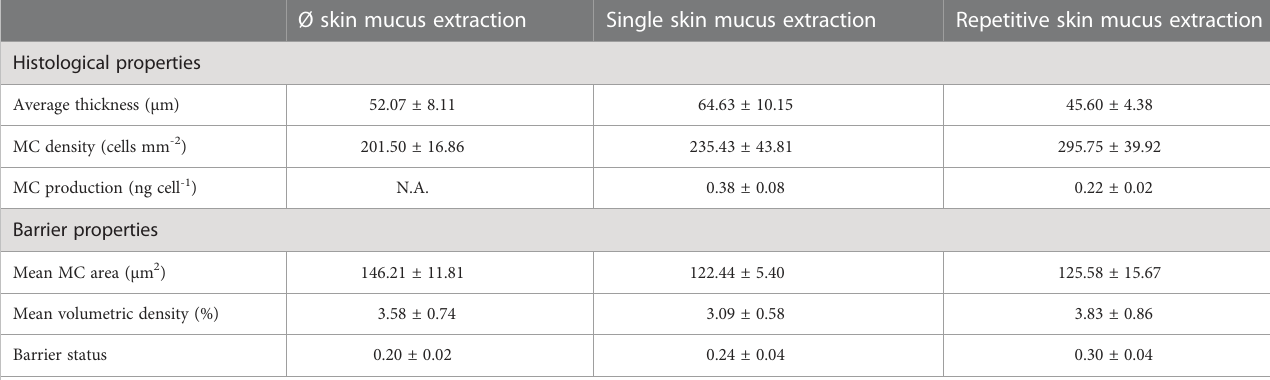
TABLE 3 Histological and barrier properties of gilthead sea bream skin subjected to zero, single or repetitive skin mucus extractions. Ø skin mucus